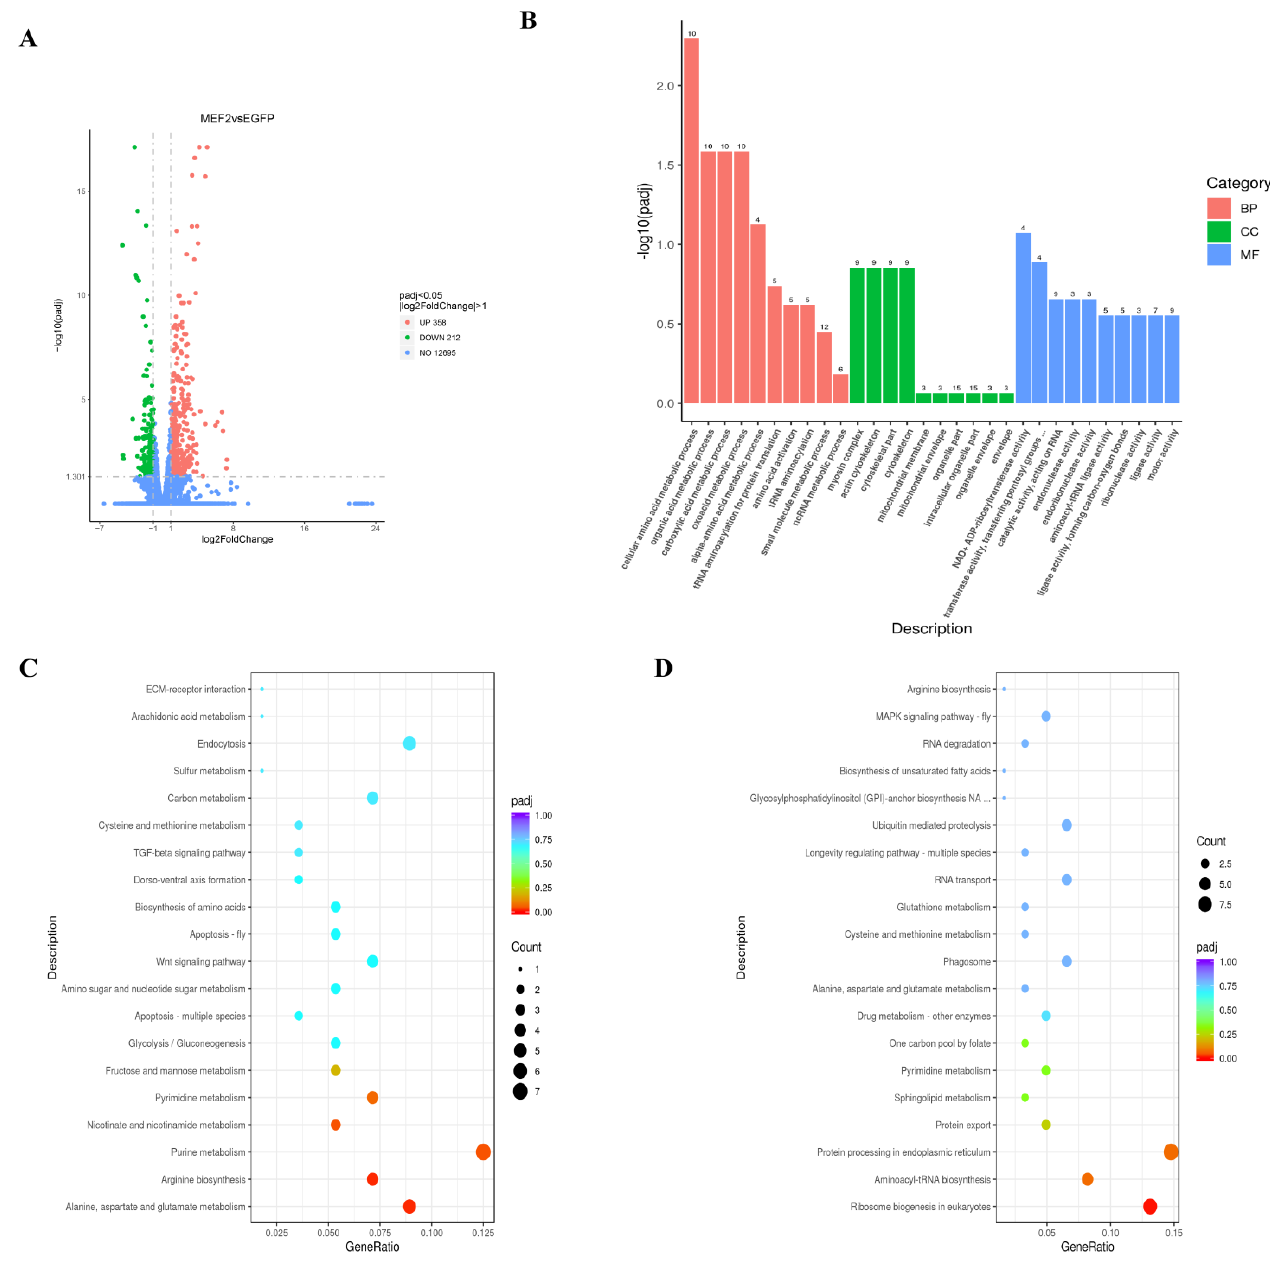
Figure 8. Differentially expressed genes after LvMEF2 knockdown and their functional enrichment analysis. ( A ) Volcano plot displays DEGs between the dsMEF2 group and the EGFP control group. Blue dots indicate non - significant differential expressions, red dots indicate significantly up - regulated expressions, and green dots indicate significantly down - regulated expressions. ( B ) GO term (level 2) distribution for the DEGs. The horizontal axis is the GO term, and the vertical axis is the significance level of GO term enrichment, which is represented by −log10(padj). Padj is the p - value after multiple hypothesis testing corrections; the higher the value, the more significant it is. Different colors represent the three GO subcategories: BP (biological process), CC (cellular com- ponent), and MF (molecular function). ( C ) The top 20 KEGG pathways enriched in muscle for up - regulated DEGs. The abscissa is the ratio of the number of differential genes annotated to the KEGG pathway to the total number of differential genes, and the ordinate is the KEGG pathway. ( D ) The top 20 KEGG pathways enriched in muscle for down - regulated DEGs.